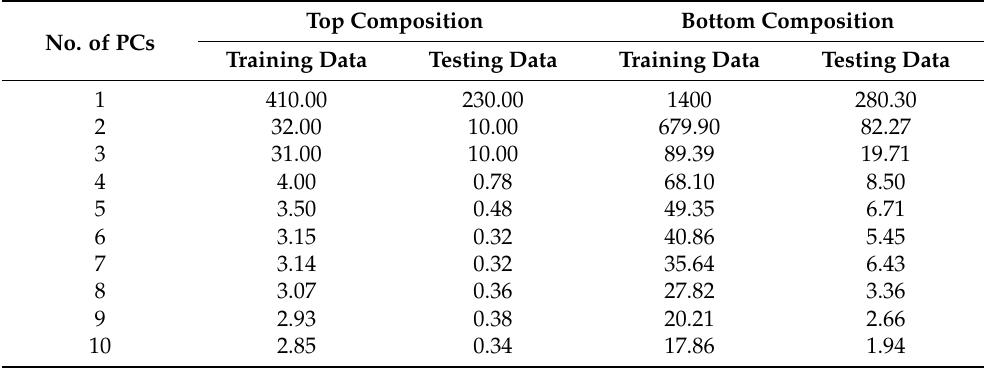
Table 2. SSE on training and testing data for static PCR models with different numbers of principal components.